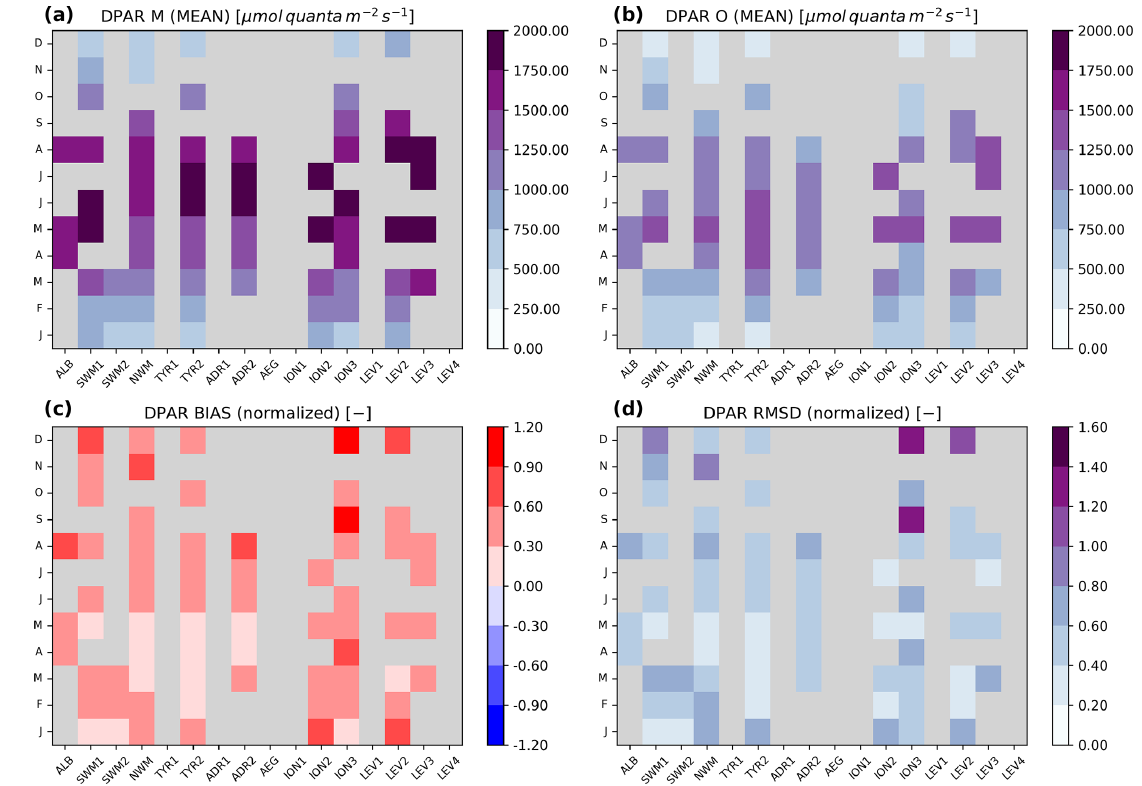
Figure 11. Same as Fig. 8 for DPAR; in this case, the mean values are expressed in µmolquantam − 2 s − 1